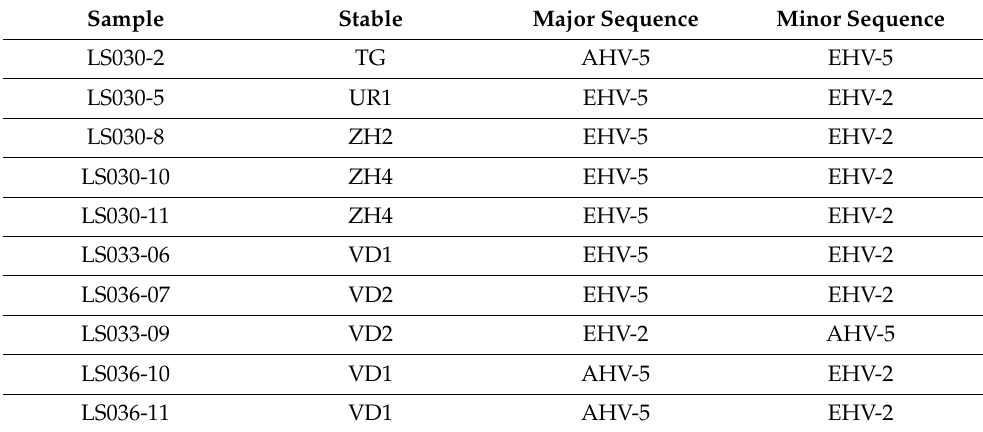
Table 1. Equid gamma herpesvirus coinfections as determined by in silico separation of superimposed electropherograms (Figure